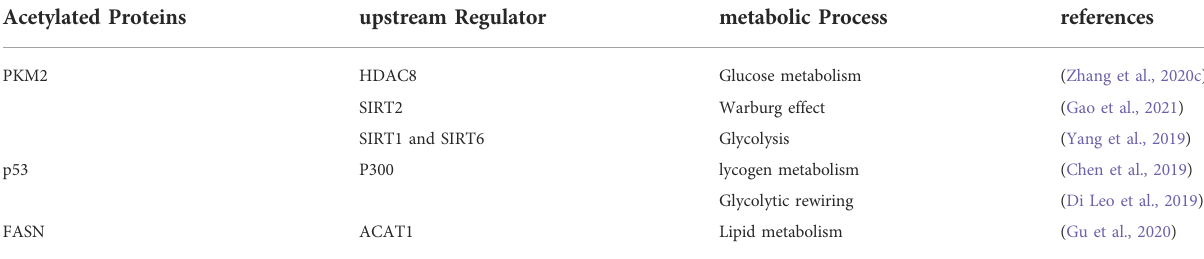
TABLE 1 Key proteins modi fi ed by acetylation during HCC